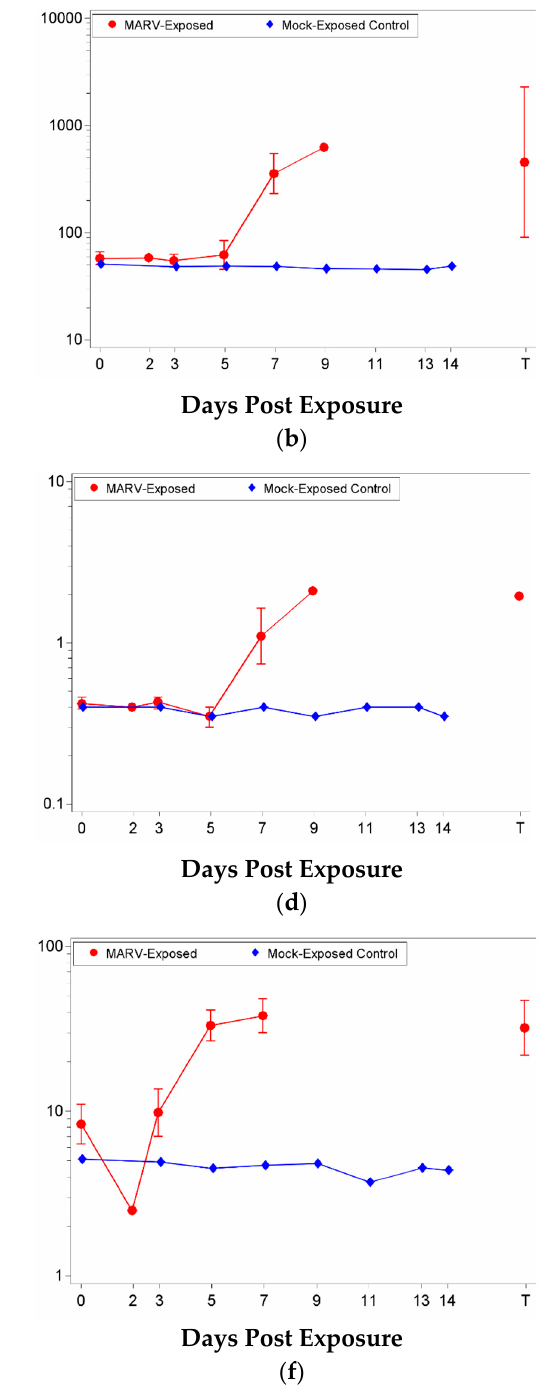
Figure 5. Mean with 95 percent confidence intervals over the course of the study for clinical chemistry parameters. Confidence interval was not plotted for sample size less than 3. Unless otherwise noted, values were log ‐ transformed, and the geometric mean is displayed. Terminal (T)—Terminal data collected from animals that met euthanasia criteria (unscheduled euthanasia) were combined and reported as a single time point. On Day 9, Animal 584 values for ALT, BA, and CRP were not able to be detected (likely as a result of being too high, out of range) and thus are not graphed. ( a ) ALT; ( b ) GGT; ( c ) BA; ( d ) TBIL; ( e ) ALB—this parameter was not log ‐ transformed, arithmetic mean displayed; ( f ) CRP.